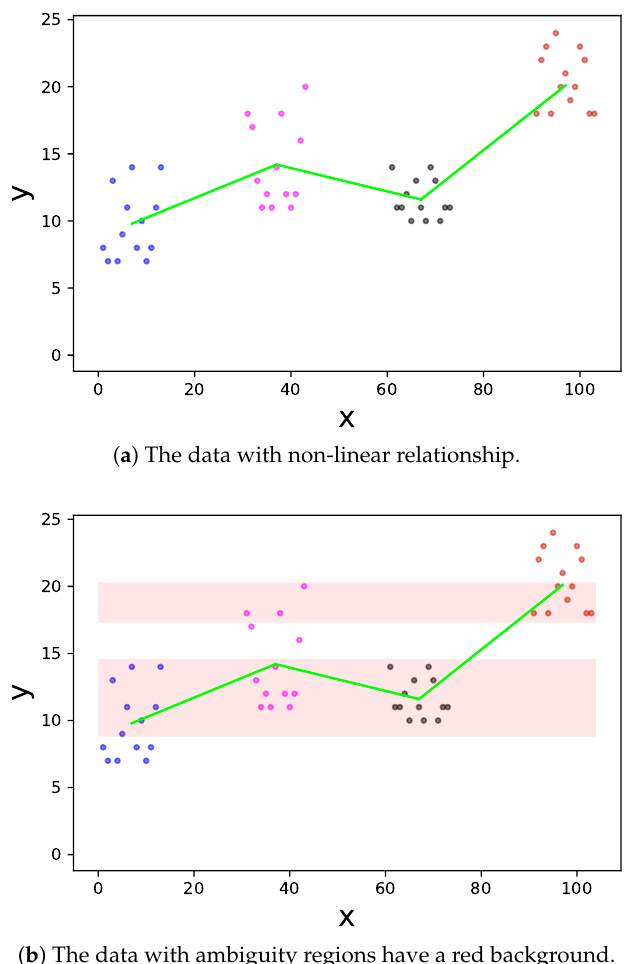
Figure 2. A motivational example of a low between-group